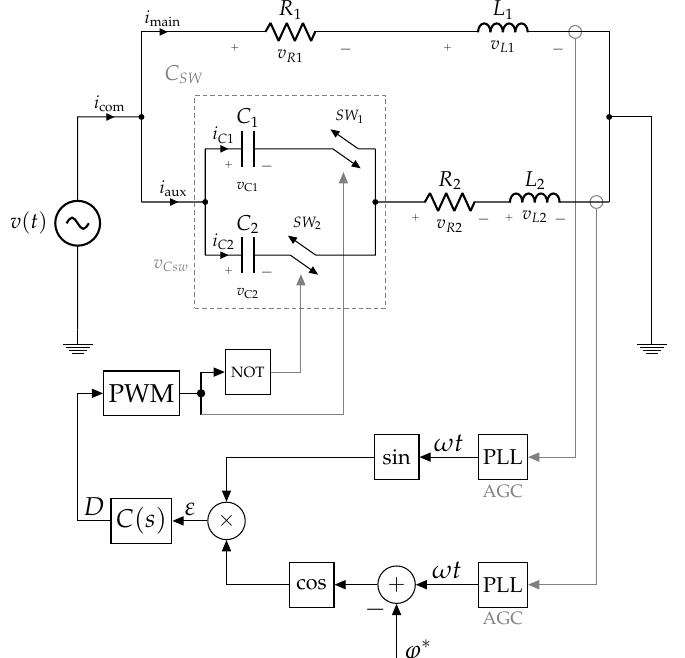
Figure 14. Block diagram of the closed-loop control of current phase advancing with the mixer as a phase detector.